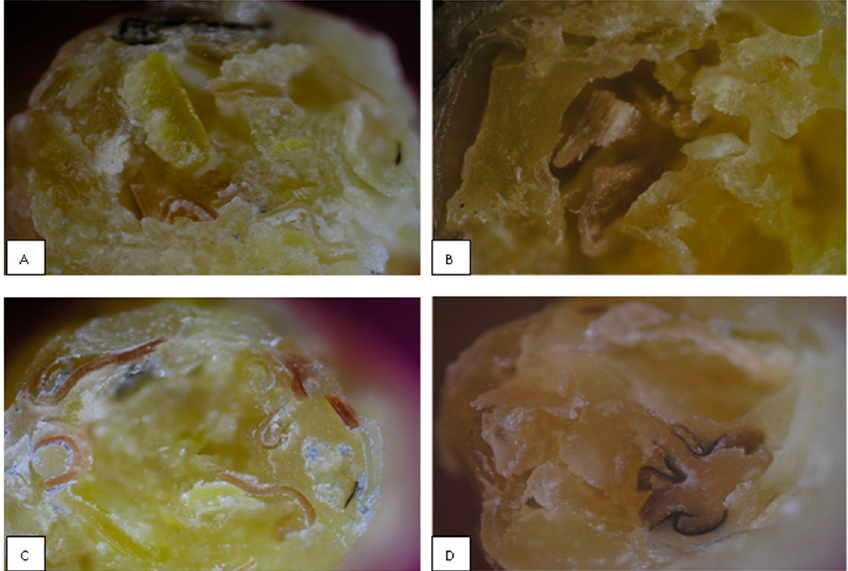
Figure 12. Microscopic pictures of extruded corn bran processed at 90 rpm extruder screw speed and at: ( A ) 20% moisture level, ( B ) 25% moisture level, ( C ) 30% moisture level and ( D ) 35% moisture level.